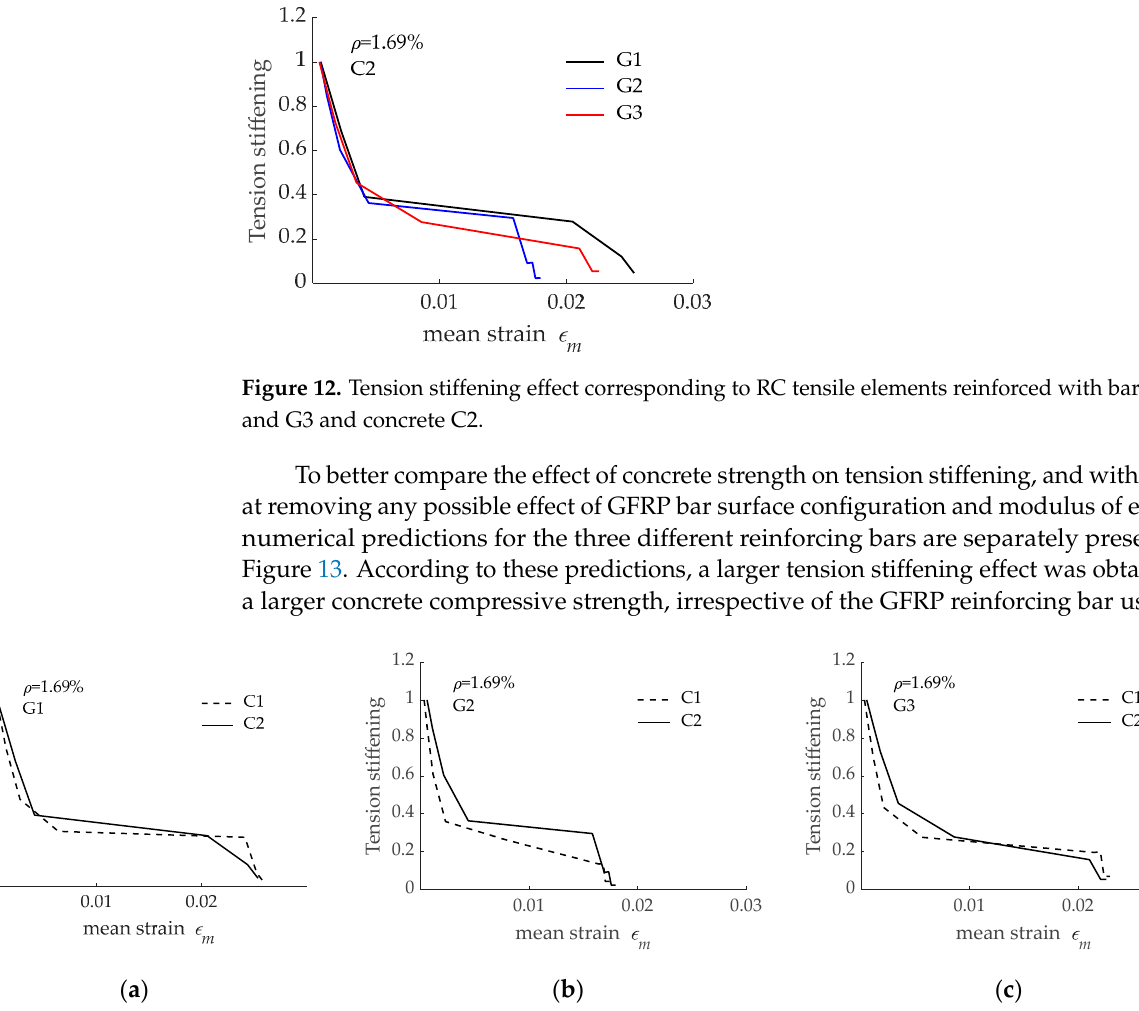
Figure 13. Effect of concrete compressive strength on tension stiffening effect for RC tensile elements ( ρ = 1.69%) reinforced with: ( a ) G1 bar; ( b ) G2 bar; ( c ) G3 bar.